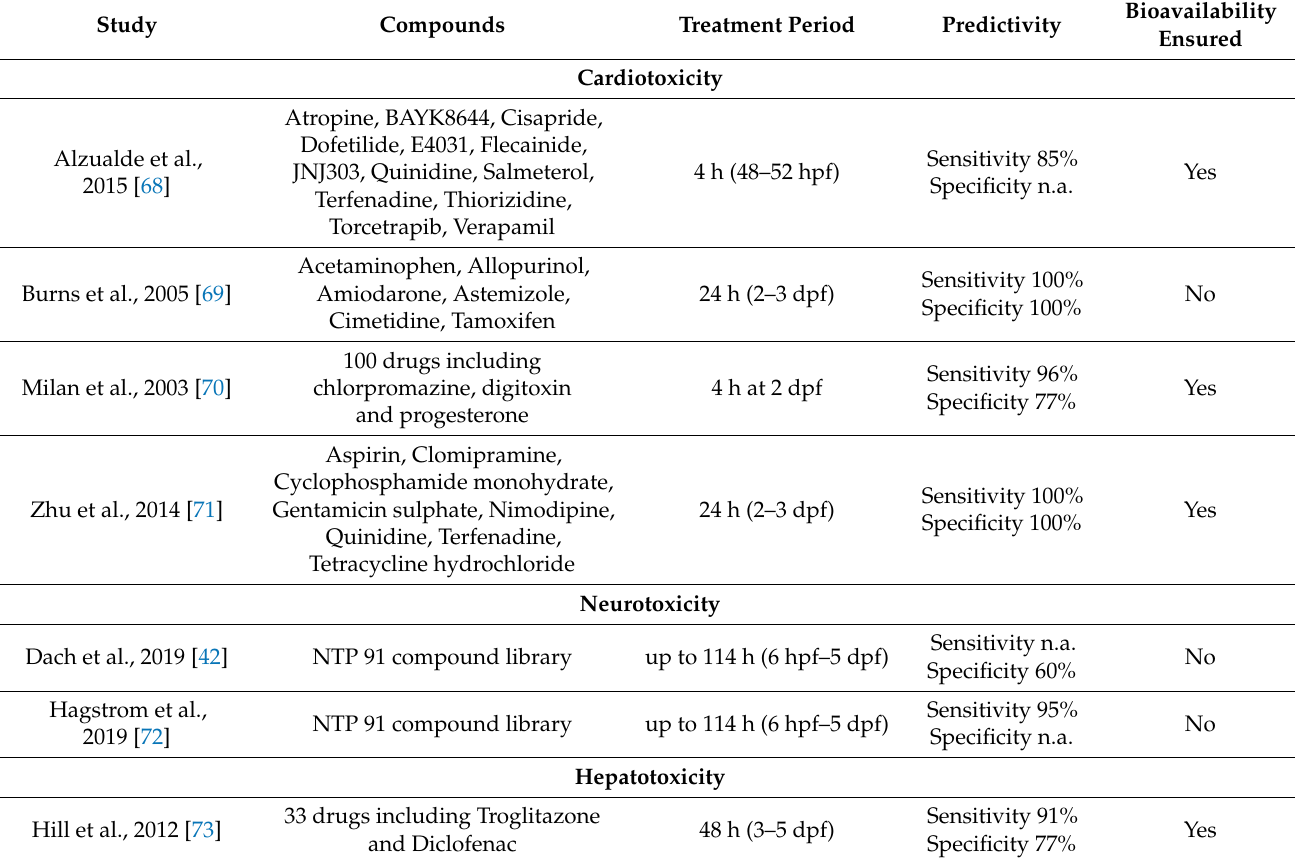
Table 1. Comparison of zebrafish toxicological compound studies with focus on cardio-, neuro-, hepato- and nephrotoxicity. Study Compounds Treatment Period Predictivity